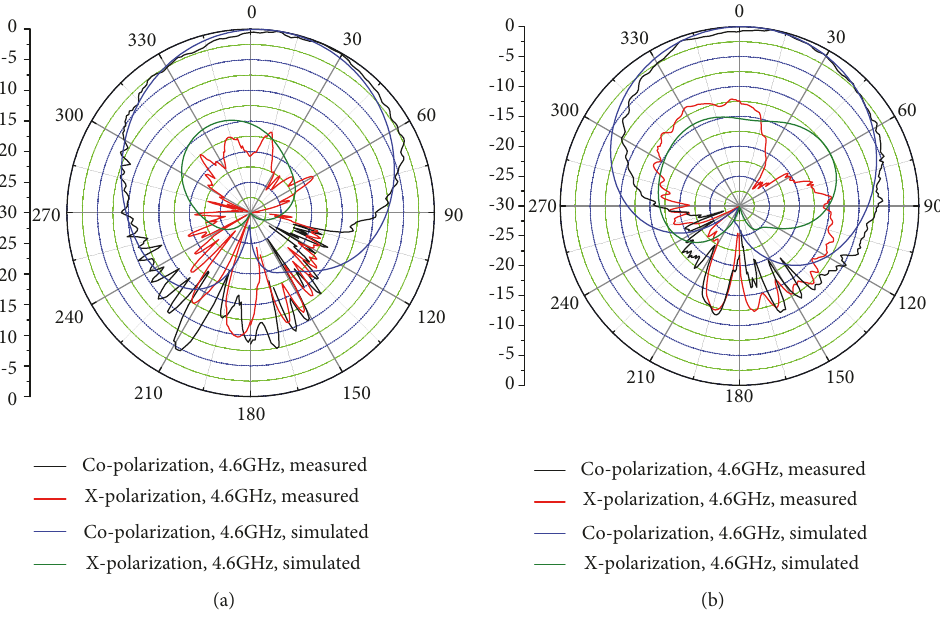
Figure 14: Measured and simulated radiation patterns of mode B: (a) E plane; (b) H